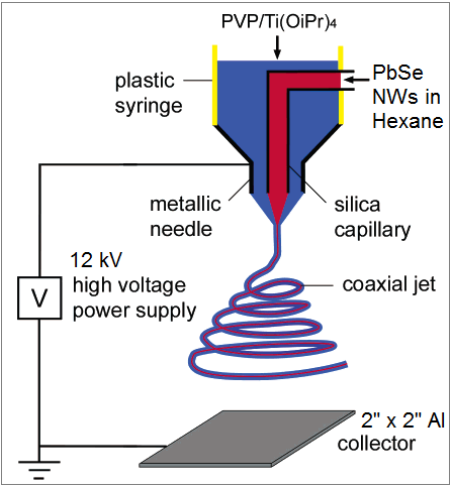
Figure 4. A schematic illustration of the co-axial spinneret, adapted with permission from [29]. Copyright 2004 American Chemical